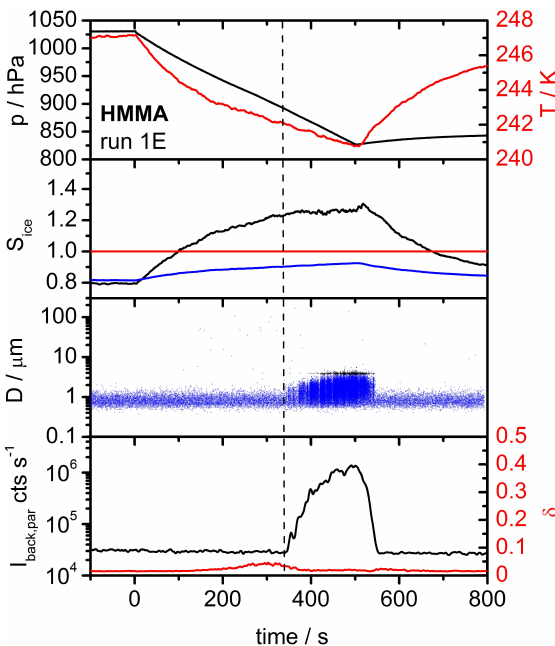
Fig. 6. Time series of various AIDA records during expansion run 1E with HMMA. Compared to the right part of Fig. 4, the fourth panel showing N ice is omitted because only a negligible number concentration of ice particles has been formed. Otherwise, the same measurements are shown.